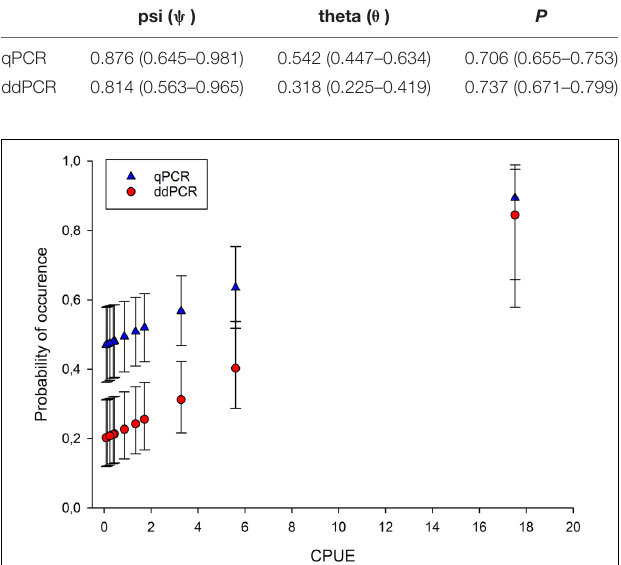
FIGURE 6 | The estimated probability of eDNA occurrence in water samples ( θ ) using occupancy models where the probability of eDNA occurrence in lakes was assumed to be constant, the conditional probability of eDNA occurrence in water samples was assumed to be a function of CPUE and the conditional probability of eDNA detection in PCR replicate was assumed to be constant.